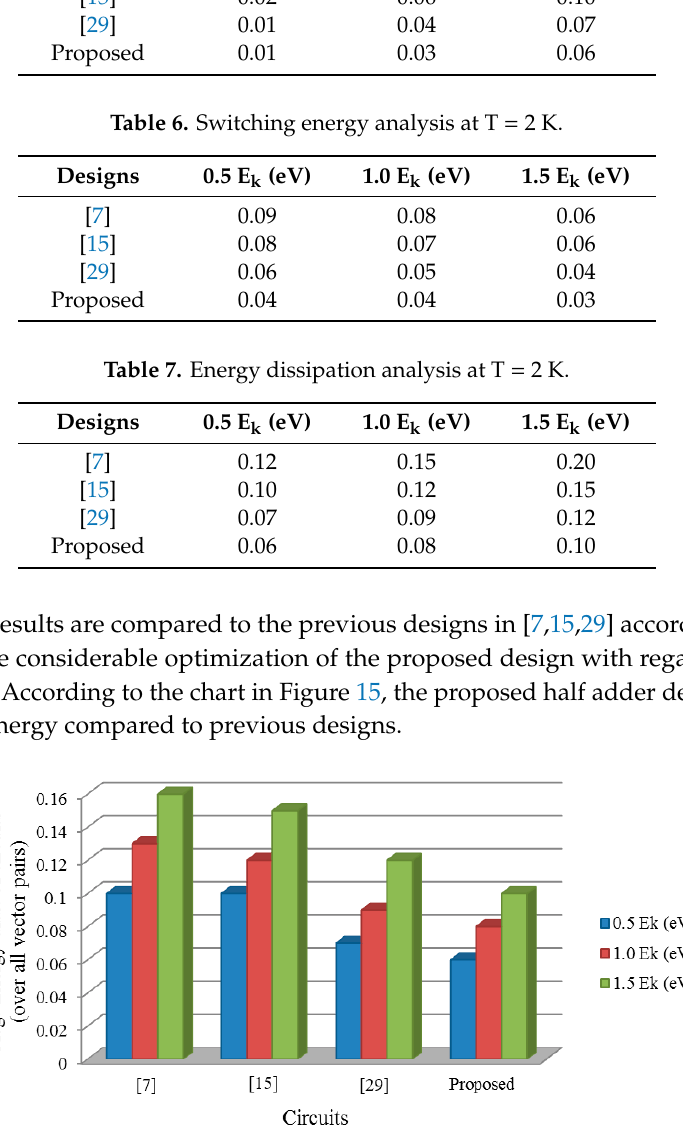
Table 5. Leakage energy analysis at T = 2 K.